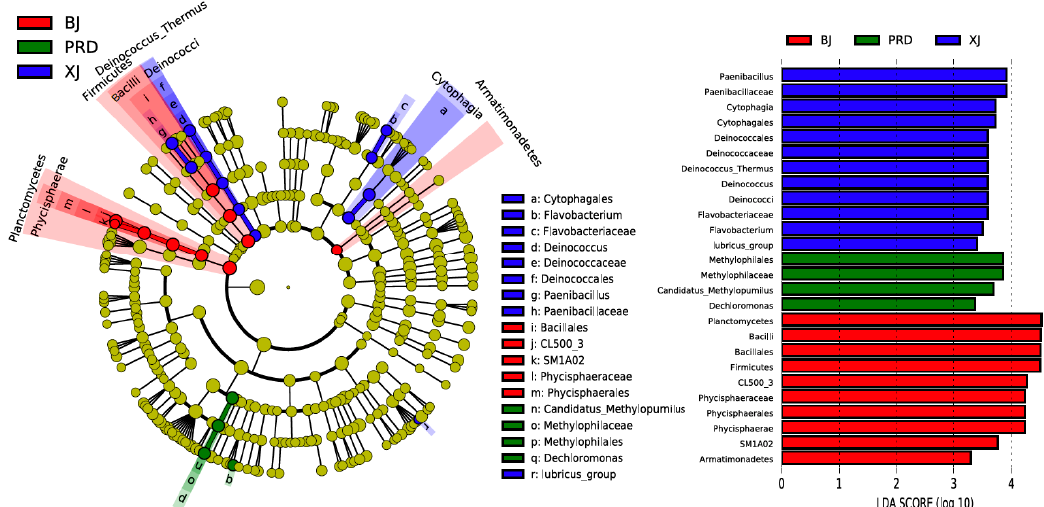
Figure 6. Linear discrimination analysis (LDA) and linear effect size (LEfSe) analysis identified most differentially abundant taxa (LDA values > 3) across the Pearl River tributaries. Differentially abundant taxa of each tributary are distinguished by different colors. Taxa without significant difference are uniformly yellow. Radiating circles from inside to out represent taxonomic levels from phylum to genus.